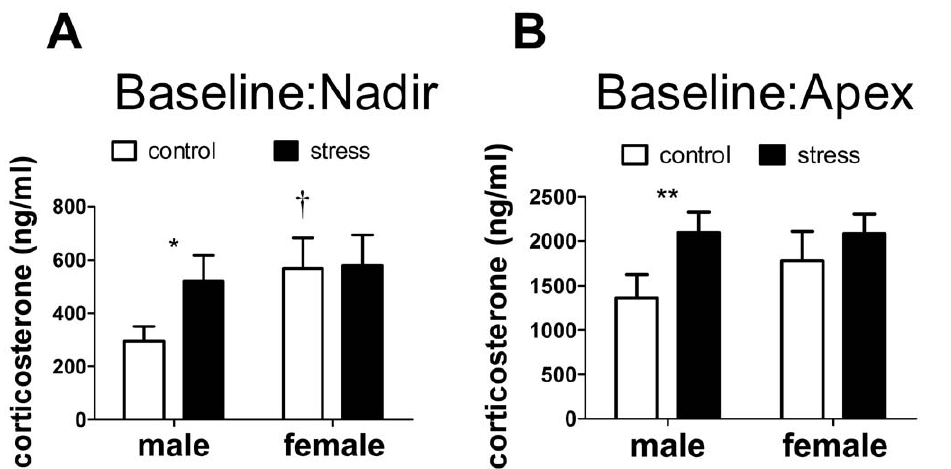
Figure 9. Effects of social defeat on corticosterone. Social defeat increased baseline corticosterone in males but not females during both the inactive (A) and active (B) phases. *, ** Mann-Whitney effect of stress p , 0.05, p , 0.01 respectively. { Mann-Whitney sex difference in controls p , 0.05. All data are mean 6 s.e.